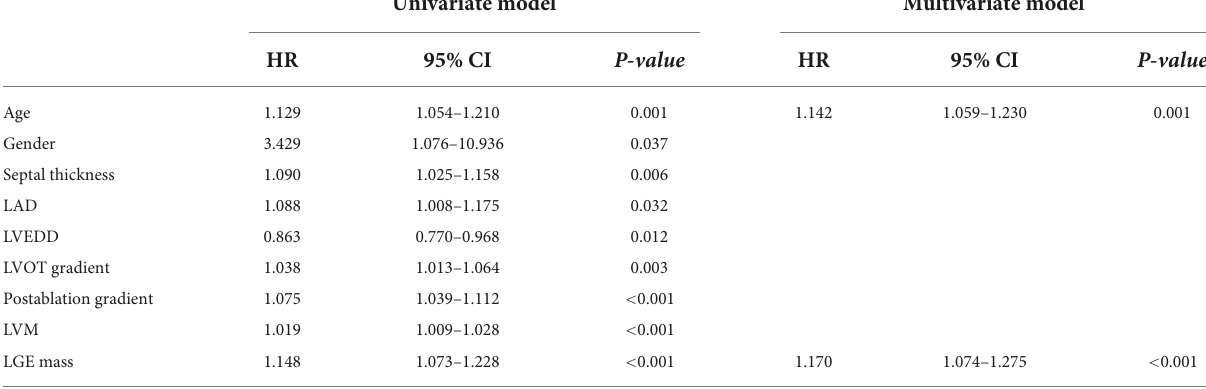
TABLE 3 Univariate and multivariate predictor models for the composite endpoint of cardiovascular-related death in HCM patients undergoing ASA. Univariate model